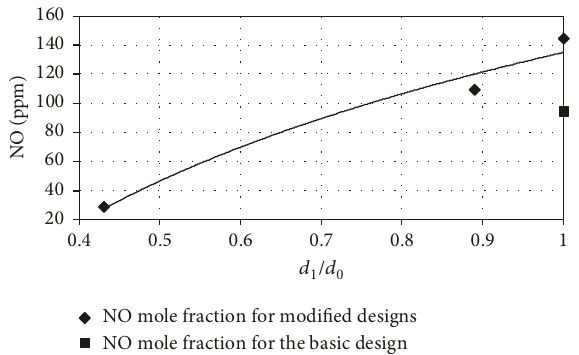
Figure 18: Emission of nitrogen oxides NO in the combustor operating on synthesis gas.